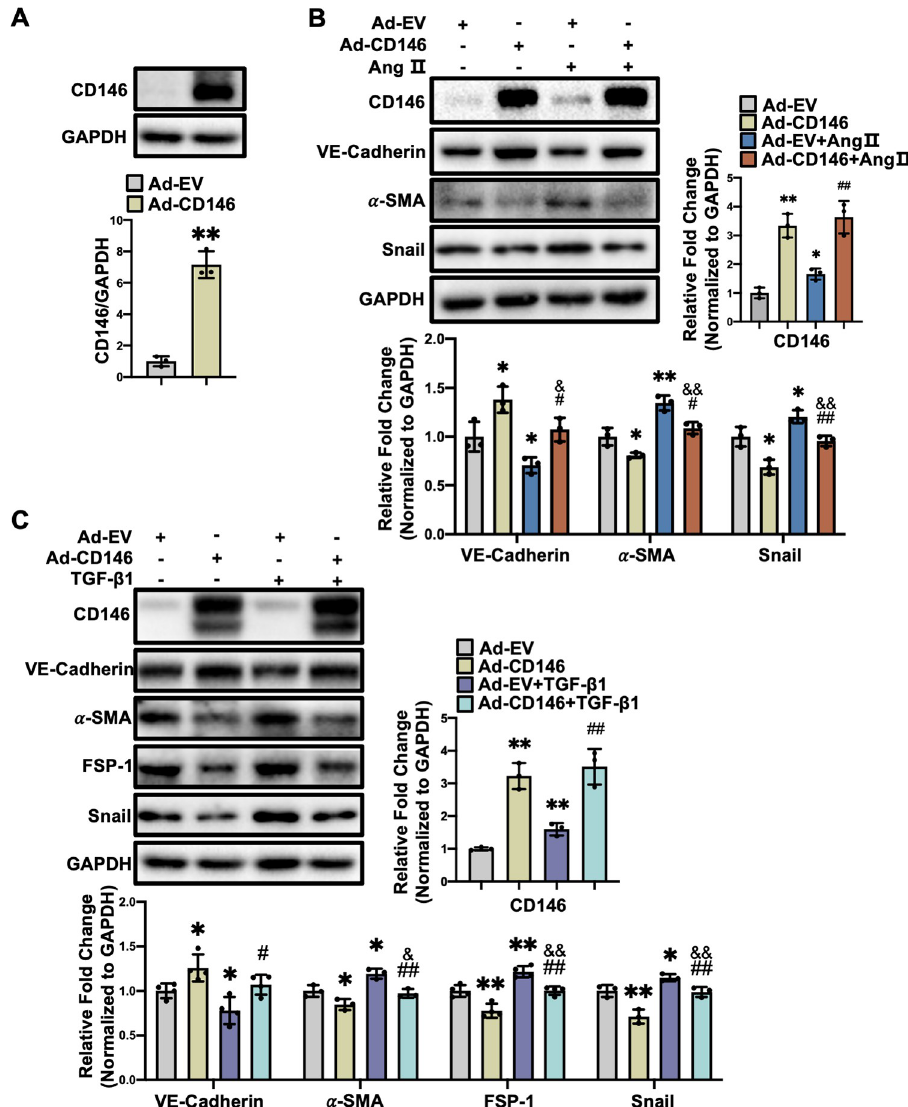
Fig 6. Overexpression of CD146 suppresses Ang II–and TGF– β 1–induced EndMT in HUVECs. A HUVECs were infected with Ad–EV and Ad–CD146 for 48 h. The protein level of CD146 was measured by Western blot analysis. GAPDH served as an internal control. HUVECs were infected with Ad–EV or Ad–CD146 for 48h followed by Ang II (1 × 10 − 6 mol/L) ( B ) or TGF– β 1 (10 ng/ml) ( C ) treatment for 48h. The protein levels of CD146, VE–Cadherin, α –SMA, FSP–1, and Snail were measured by Western blot analysis. GAPDH served as an internal control. � P < 0.05, �� P < 0.01 vs . Ad–EV, # P < 0.05, ## P < 0.01 vs . Ad–EV+ Ang II or TGF– β 1. & P < 0.05, && P < 0.01 vs . Ad–EV. Ad–EV: Ad–empty